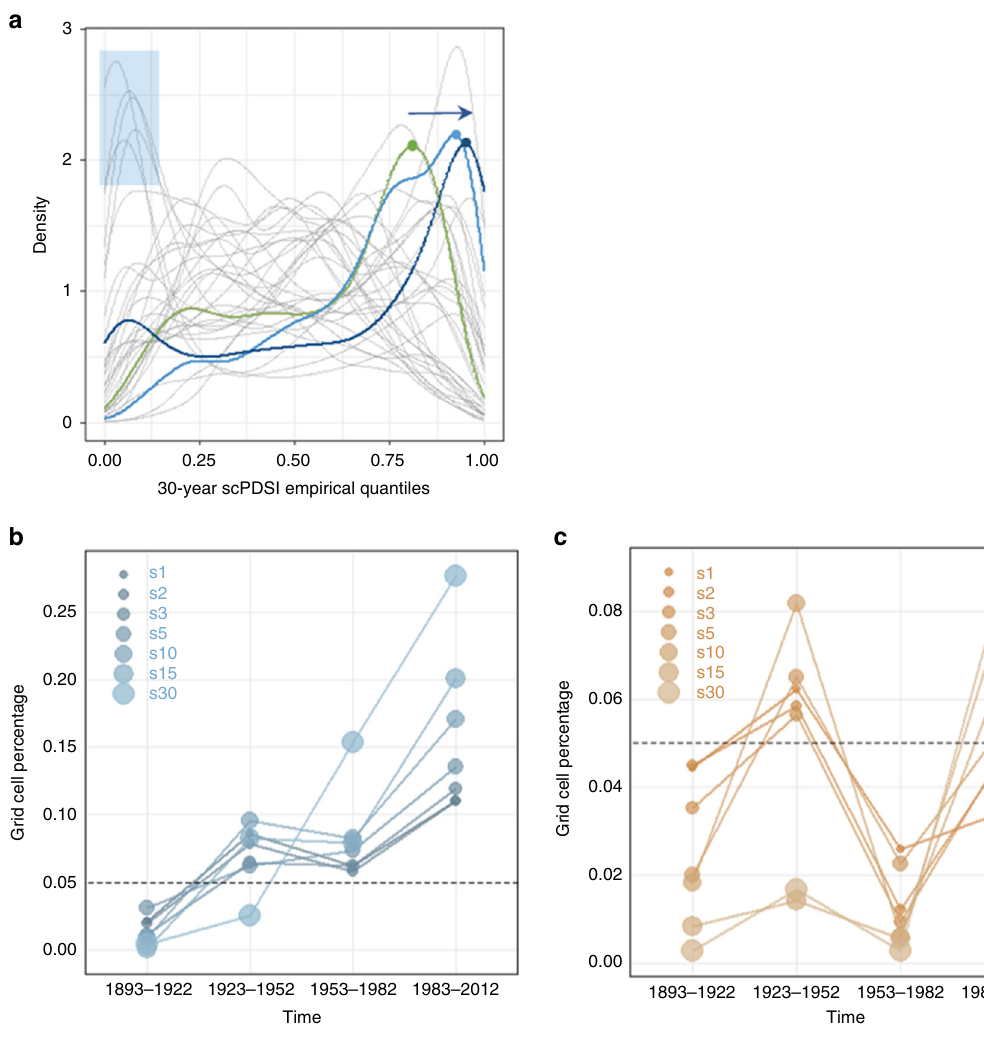
Fig. 2 Temporal evolution of hydroclimatic conditions over 1892 − 2012. a Empirical probability densities of 30-year scPDSI values over Europe (grey lines: different 30-year intervals for the 992 − 1922 period, green line: 1923 − 1952 interval, light blue line: 1953 − 1982 interval, dark blue line: 1983 − 2012 interval). The blue arrow represents the temporal evolution of the last three 30-year intervals (green to light blue to deep blue). The dry periods are also highlighted by the blue transparent rectangle. Values close to zero (close to one) represent extremely dry (extremely wet) conditions. b Percentage of grid cells with scPDSI above the 0.95 quantile for time scales 1 to 30 years (extreme pluvial conditions). c Similar to b but for the bottom 0.05 quantile (extreme dry conditions). Grey dashed line represents the theoretical quantile value, i.e., the top/bottom 5% of the grid